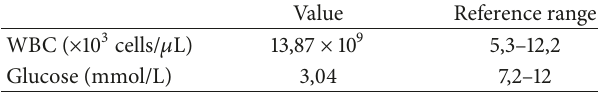
Table 1: Normal values obtained from [14].